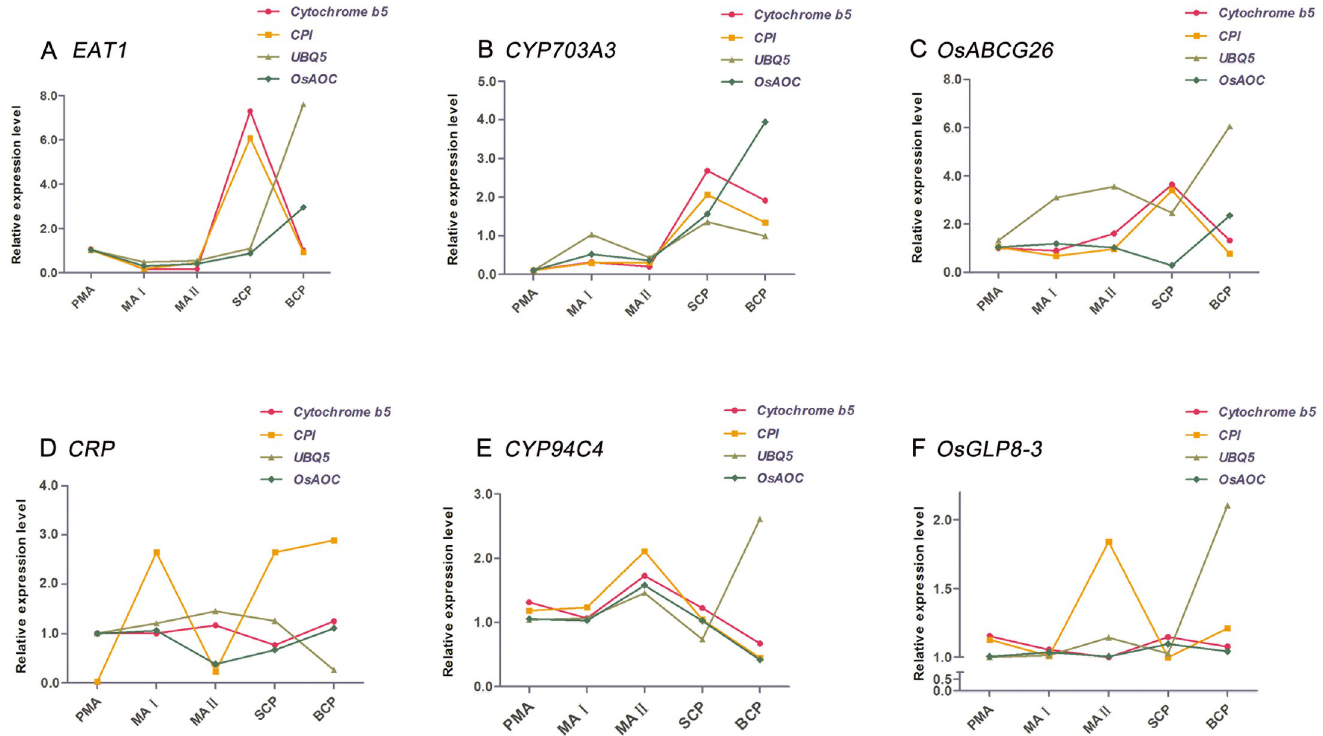
Fig 6. Relative expression of pollen development related and stage specific genes using the selected reference genes for normalization. (A) The expression of EAT1 in different pollen development stages was normalized using the most stable genes and least stable reference genes. (B) The expression of CYP703A3 in different pollen development stages was normalized using the two most stable genes and least stable reference genes. (C) The expression of OsABCG26 in different pollen development stages was normalized using the most stable genes and least stable reference genes. (D) The expression of CRP in different pollen development stages was normalized using the most stable genes and least stable reference genes. (E) The expression of CYP94C4 in different pollen development stages was normalized using the most stable genes and least stable reference genes. (F) The expression of OsGLP8-3 in different pollen development stages was normalized using the most stable genes and least stable reference genes ( UBQ5 and OsActin1 ). PMA indicate the samples of pre-meiosis stage in diploid and autotetraploid rice; MAI indicate the samples of meiosis stage I in diploid and autotetraploid rice; MAII indicate the samples of meiosis stage II in diploid and autotetraploid rice; SCP indicate the samples of single microspore stage in diploid and autotetraploid rice; BCP indicate the samples of bicellular pollen stage in diploid and autotetraploid rice.